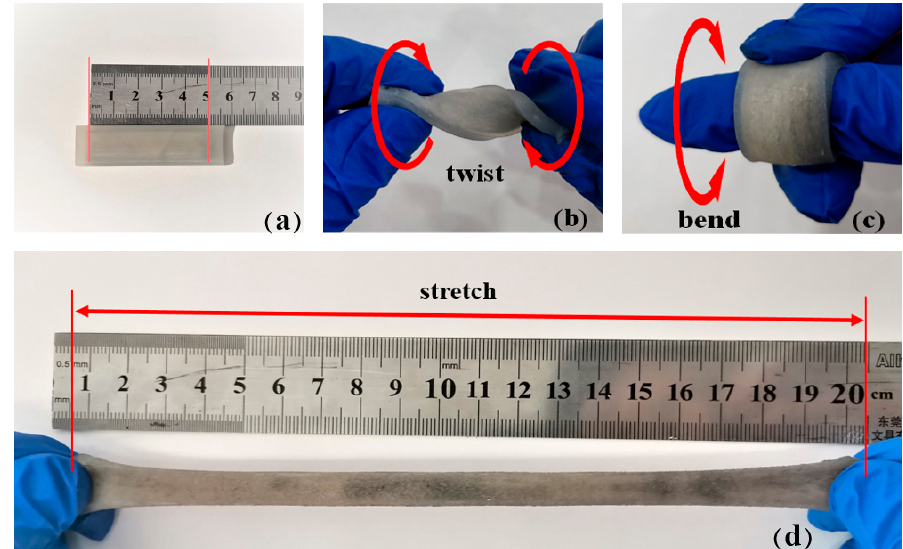
Figure 6. Liquid-metal embedded silicone elastomer has good flexibility and stretchability. ( a ) Fabricated liquid-metal embedded silicone elastomer; Twisting ( b ), bending ( c ), and stretching ( d ) of the fabricated liquid-metal embedded silicone elastomer.